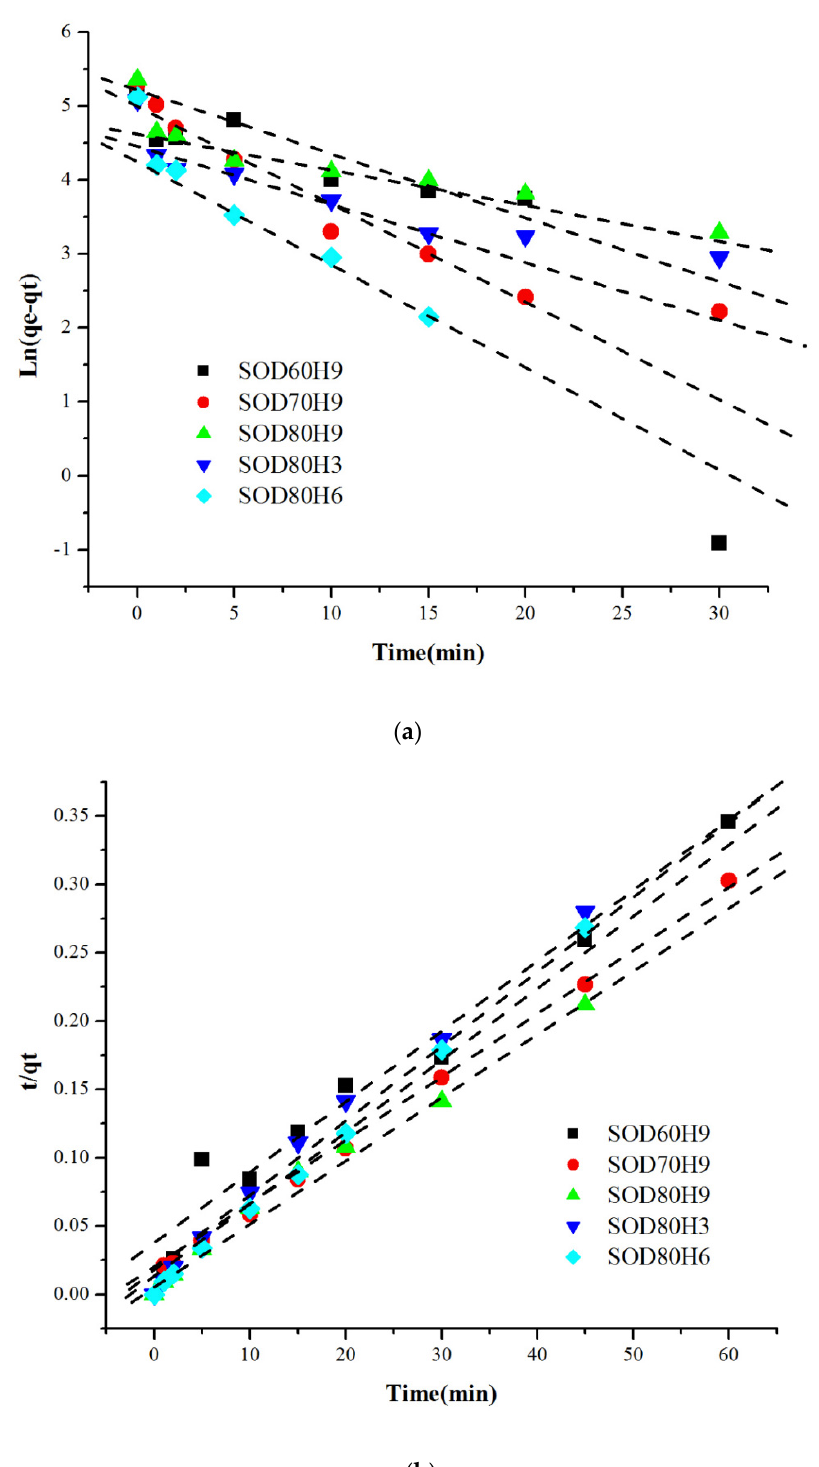
Figure 9. Kinetics of Pb 2+ adsorption on SOD samples with CTABr with ( a ) pseudo-first-order and ( b ) pseudo-second-order models (Co = 100 ppm, V = 0.2 L, W = 0.05 g). The adsorption of Pb 2+ ions can also cause hydrolysis of sodalite, which releases sili- cate ions into the solution. According to the effective ionic radii [41], the radii of the metal ions Na + = 0.99 nm and Pb 2+ = 0.98 nm. The radii of the guest cations influenced the diffu- sion within the interconnected intrinsic nanopores/cages of sodalite. Only cations with similar ionic sizes will achieve high ion exchange capacity, as observed on Na + and Pb 2+ . The similarity of Na + and Pb 2+ sizes reduced the possibility of diffusion of other cations such as Al or Si from the main sodalite framework. The approximately similar ion radii of Na + and Pb 2+ further prevent the disintegration of the sodalite framework during the dif- fusion. Adsorption using the cation exchange process further benefits from large meso- pore diameter, which allow access into sodalite cavities for adsorption via physical inter- action. This work provides a pathway for transforming natural kaolin into sodalite materi- als. It also paves the way for a sustainable approach to designing advanced zeolite adsor- bents using hydrothermal conditions suitable for low-cost removal of heavy metal pollu- tion. However, analysis of the sodalite following adsorption with Pb 2+ is important to un- derstand the stability of adsorbent. The results of SEM-EDX S80H9 analysis (Figure 10) after adsorption showed a Pb content of 11% and a C content of 1% w/w. The presence of carbon cerrusite (PbCO 3 ) or hydrocerrusite (Pb 3 (CO 3 ) 2 (OH) 2 ) formation from the reaction between Pb and CO 2 . The ratio of Pb:C of cerrusite and hydrocerrusite should be within the range of 17.5–25.9. However, the EDX results showed the Pb:C ratio of 11, which sug- gested Pb adsorption on S80H9 only produced a small amount of cerrusite but without hydrocerrusite formation. Since high amount of Pb was absorbed on sodalite, the SEM analysis revealed the formation of larger crystals of sodalite after Pb 2+ adsorption than before the adsorption.